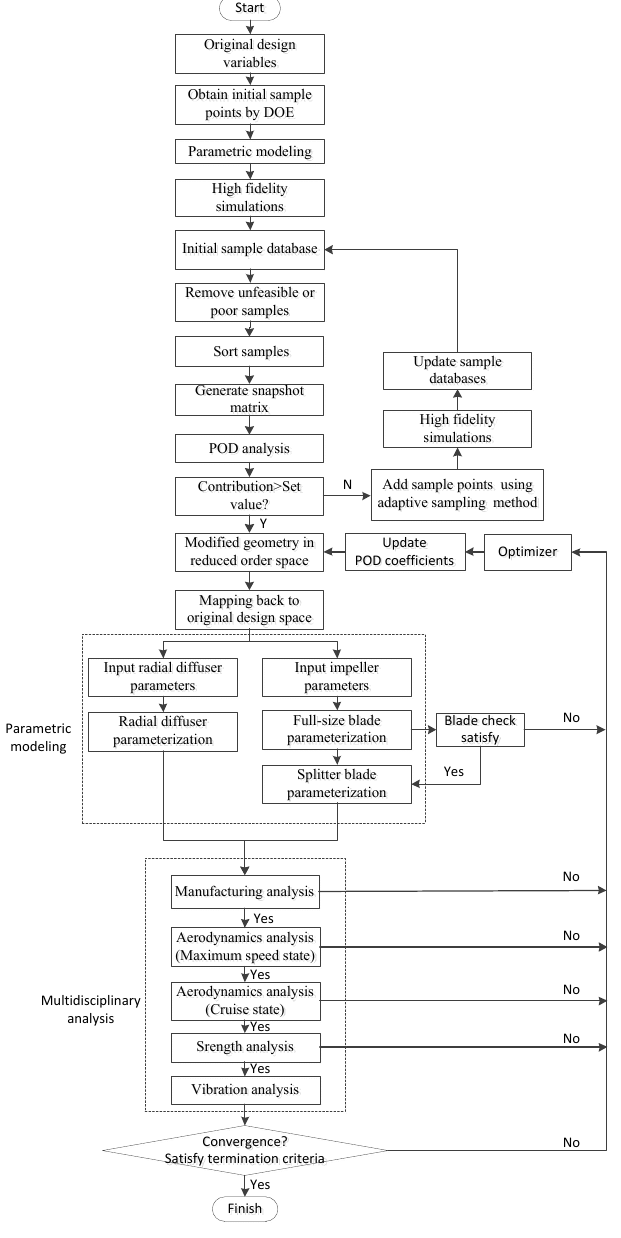
Figure 2. Optimization process.